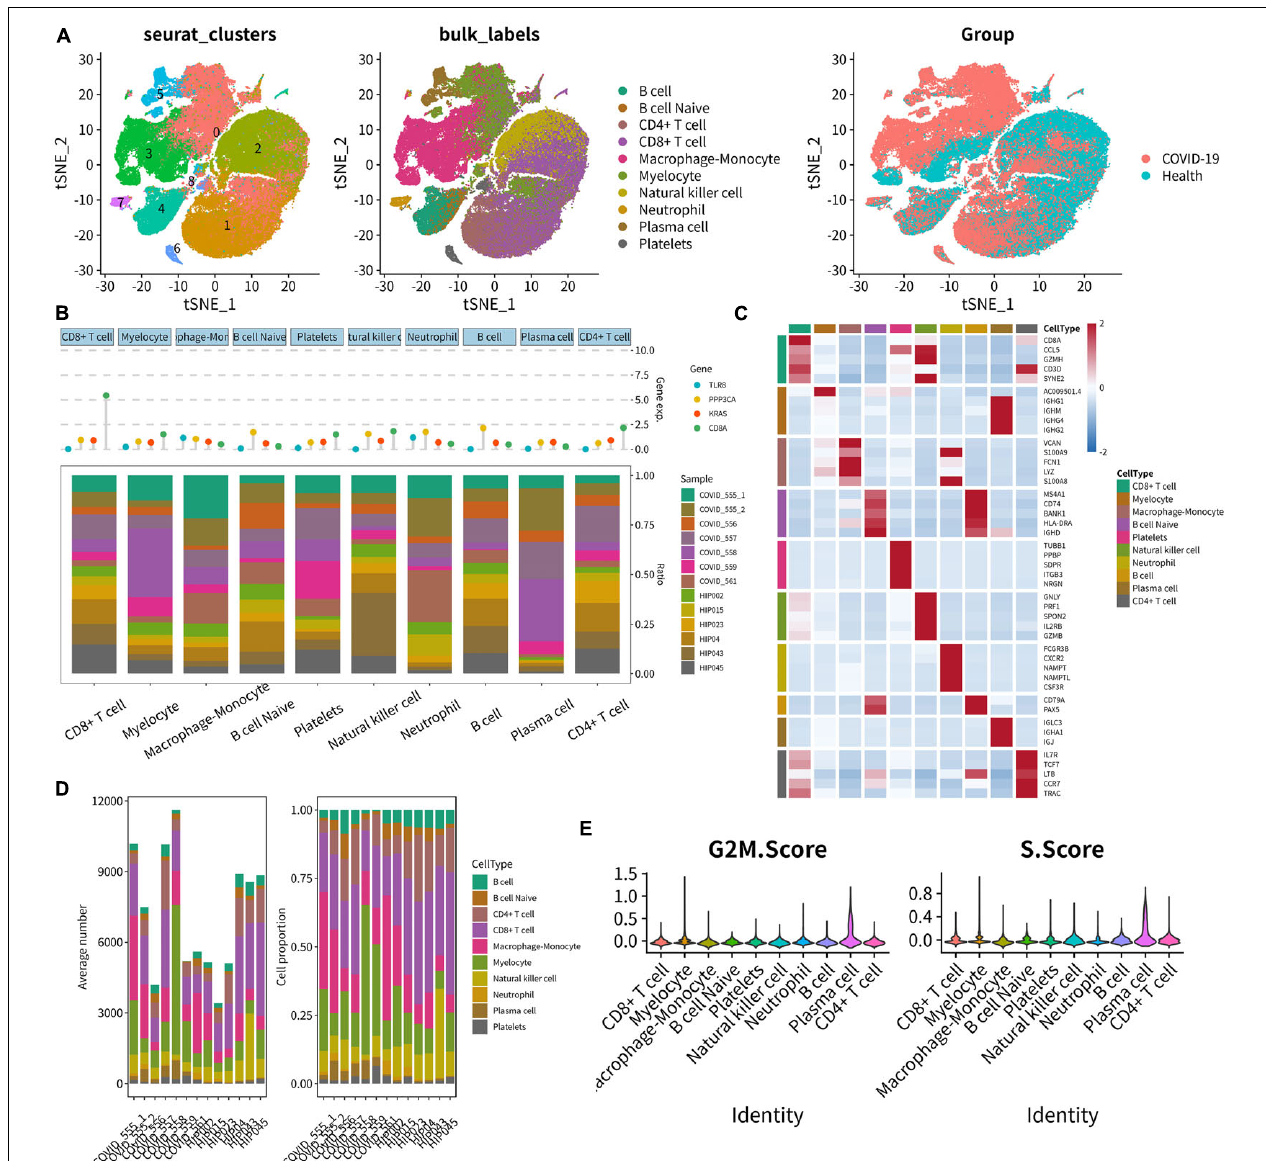
FIGURE 10 | Integrated analysis of scRNA-seq. (A) UMAP scatter plots showing 10 main cell types using unsupervised clustering. (B) Cleveland’s dot plot showing the expression levels of key SSSIRGs, which were TLR8, PPP3CA, KRAS, and CD8A; the bar plot shows the proportions of 10 cell types in each sample. (C) Heat map illustrating the expression levels of the top 5 marker genes in 10 cell clusters. (D) Bar plot illustrating the fractions of these cell types in every sample. (E) Violin plot showing the majority of these cells was in the G2M and S